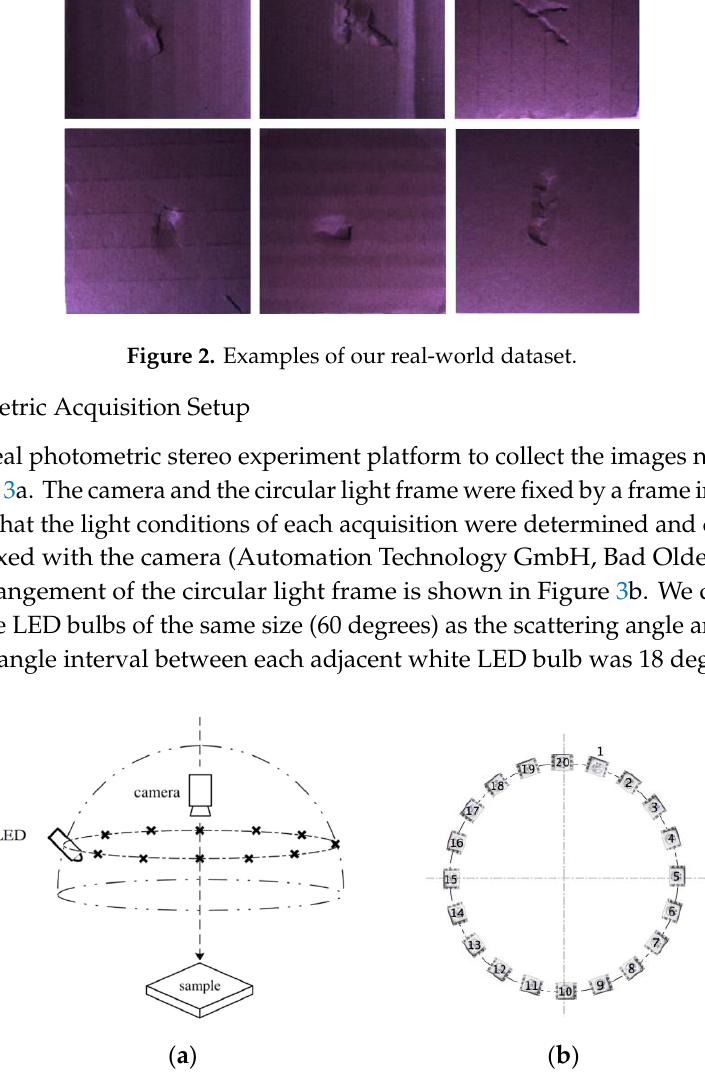
Figure 3. ( a ) The photometric acquisition setup of the multi-source Photometric Stereo. ( b ) The light configurations of our proposed setup.